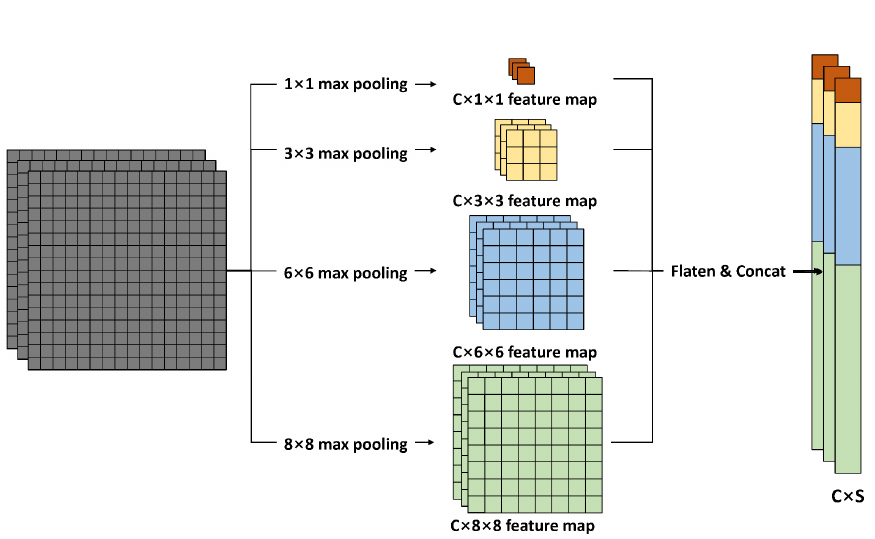
Figure 5. Structure of spatial pyramid pooling.